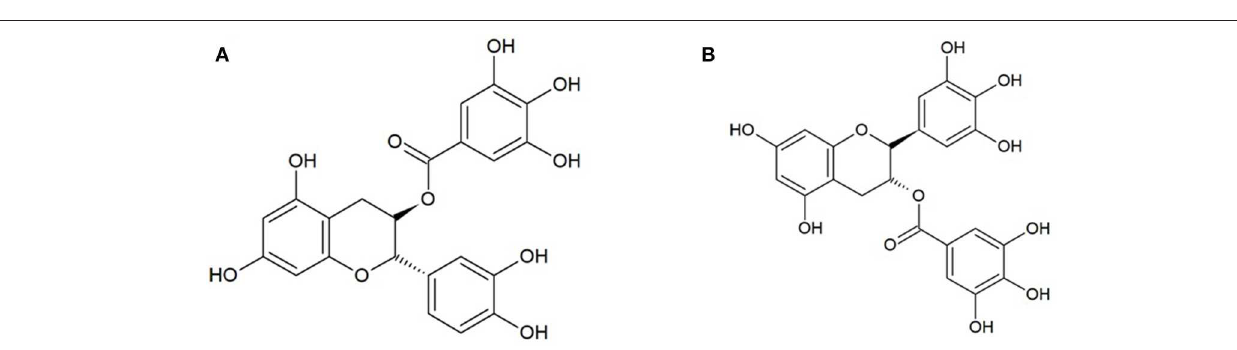
and MAPK signaling pathways and reduction of virus-induced inflammation (for the anti-HCV activity) (37). Interestingly, two in vitro studies investigated the effects of GPE against respiratory syncytial virus, using an airway epithelial A549 cell model (38, 39). In particular, it was demonstrated that GPE interfered with nucleoprotein and fusion protein expression,